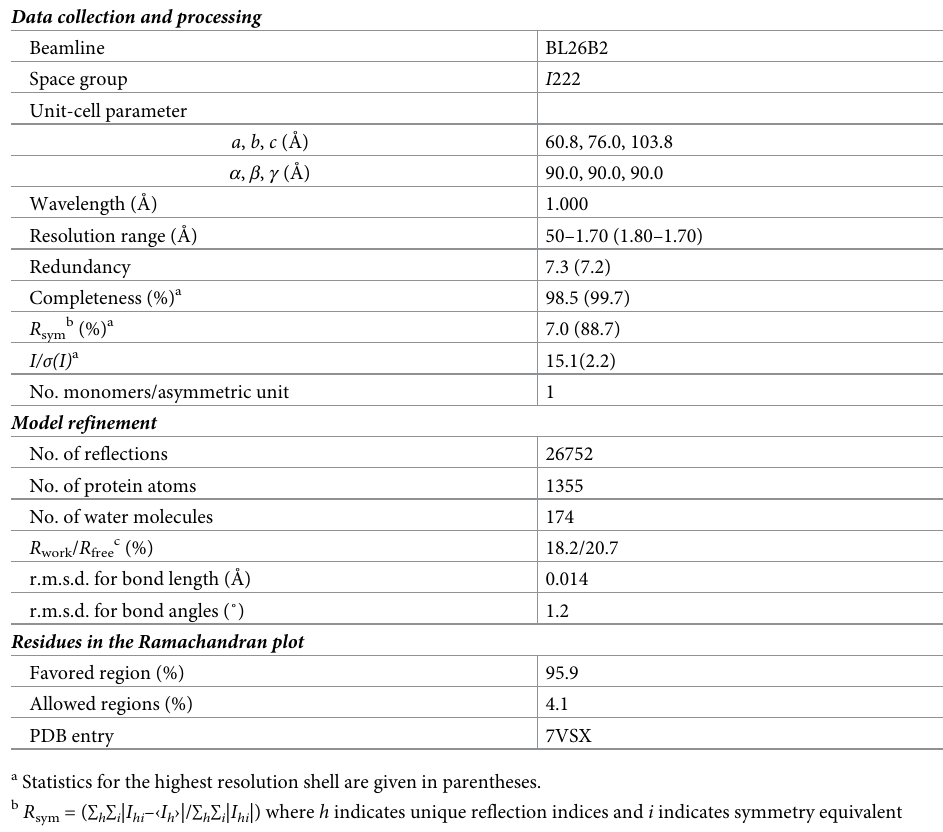
Table 9. Statistics of data collection and structure